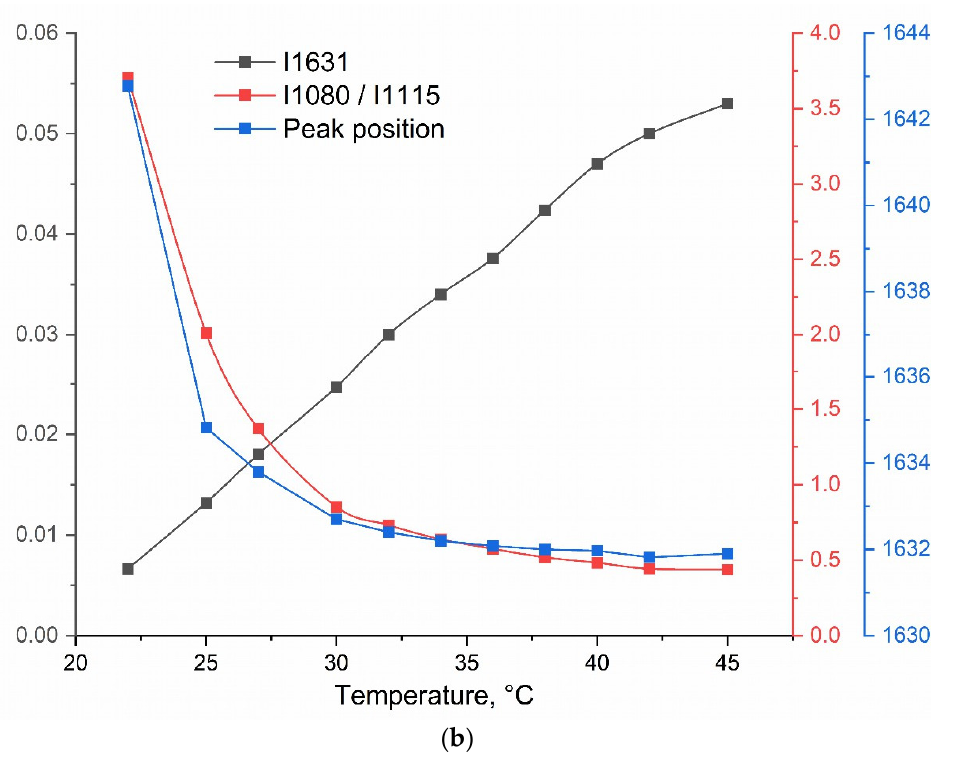
Figure 7. ( a ) FTIR spectra of Dox in Chit5-MUA-20 micelles at 22–45 °C. ( b ) Corresponding dependences of I1631, ratio I1080/I1115 (the peaks of chitosan C–O–C bonds, which characterize the ratio of the hydrophilic to hydrophobic component of chitosan), and 1630–1640 cm –1 peak position (the C=O bond, which characterizes the microenvironment of the carbonyl group of doxorubicin, which becomes more hydrophilic) on temperature. I—intensity.